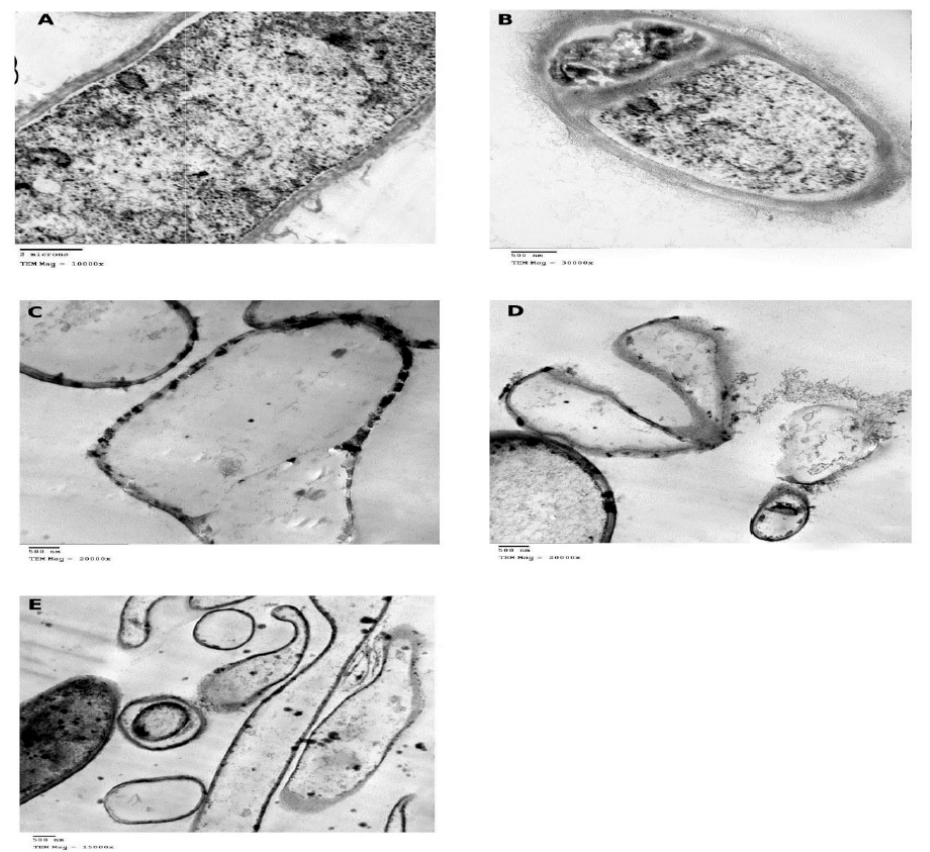
Figure 5. Transmission electron microscope (TEM) micrographs of ( A , B ) native Aspergillus awamori JQ695830.1 cells and ( C – E ) ZnONPs-treated A. awamori .